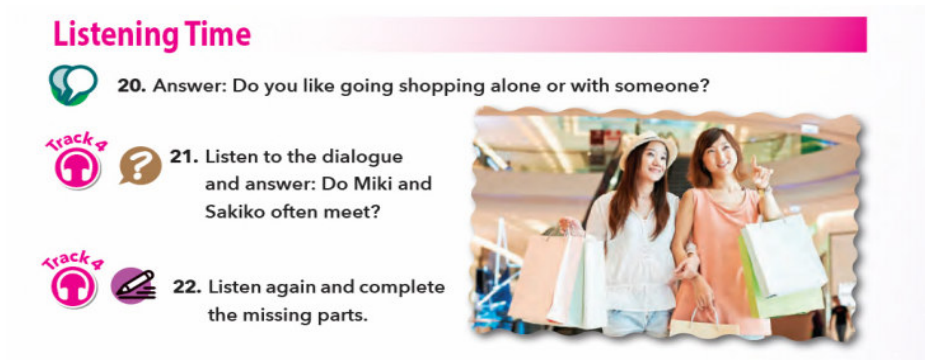
Figure 1. Miki and Sakiko (p.